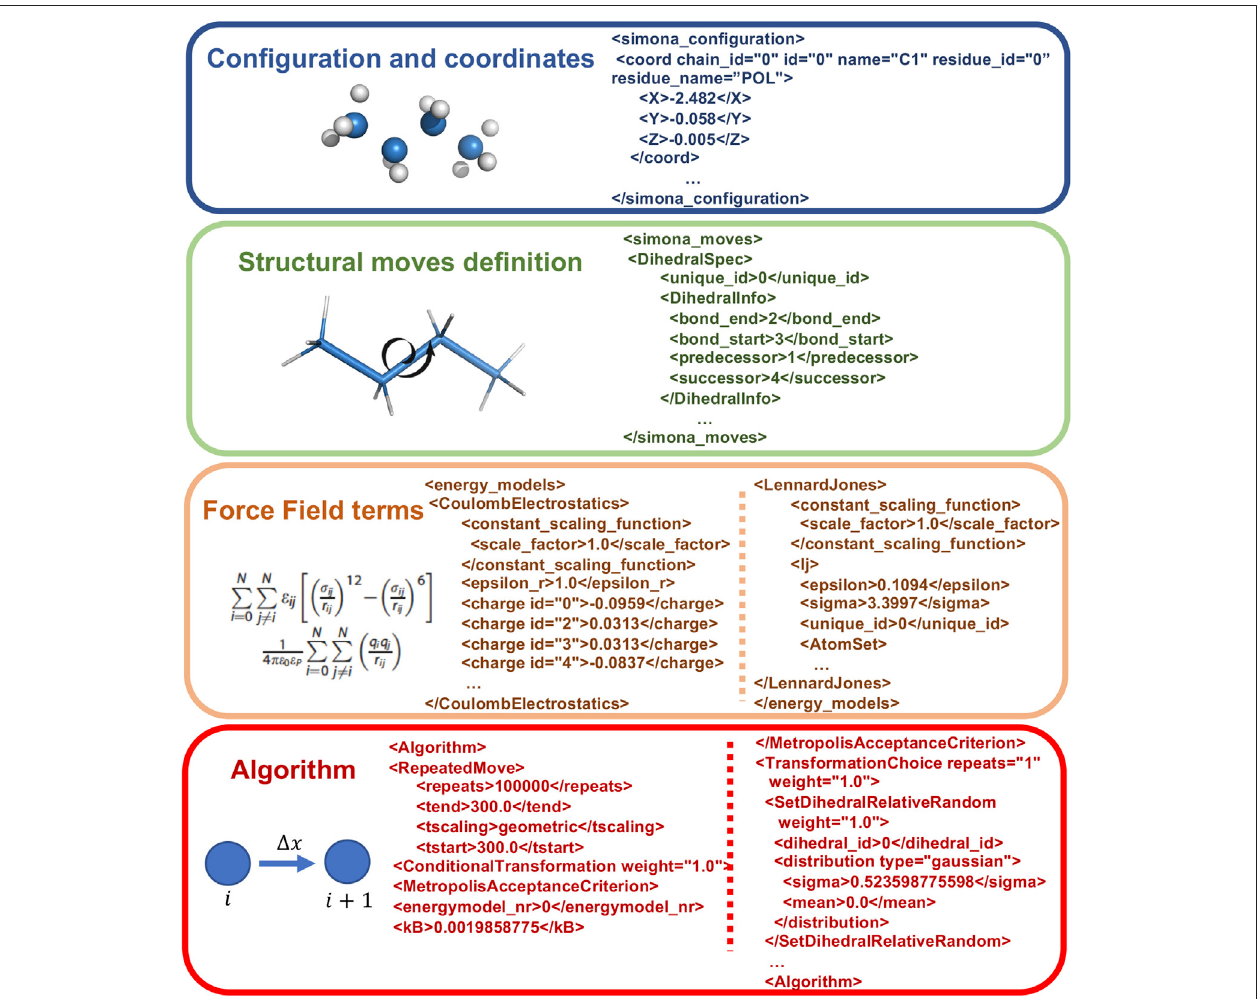
FIGURE3| ExampleofStructureofXMLSIMONAinput fi ledescribingitsmainparts,suchastheCon fi gurationandcoordinates,theStructuralmovesde fi nition,FF terms to describe the system interactions and the Algorithm related to the moves